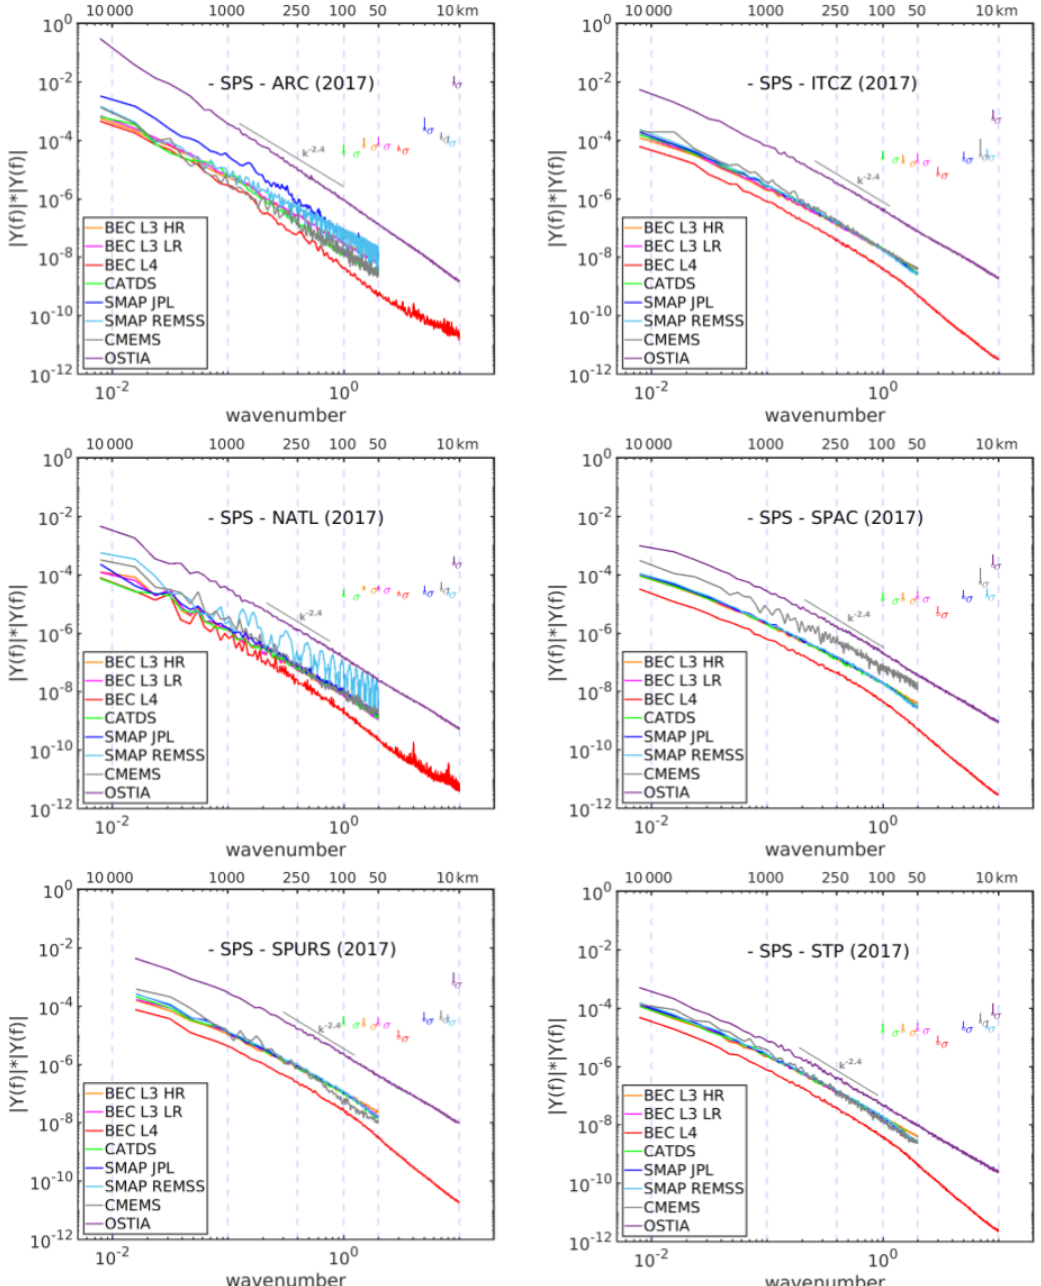
Figure 15. Singularity spectral analysis of the different SSS products.